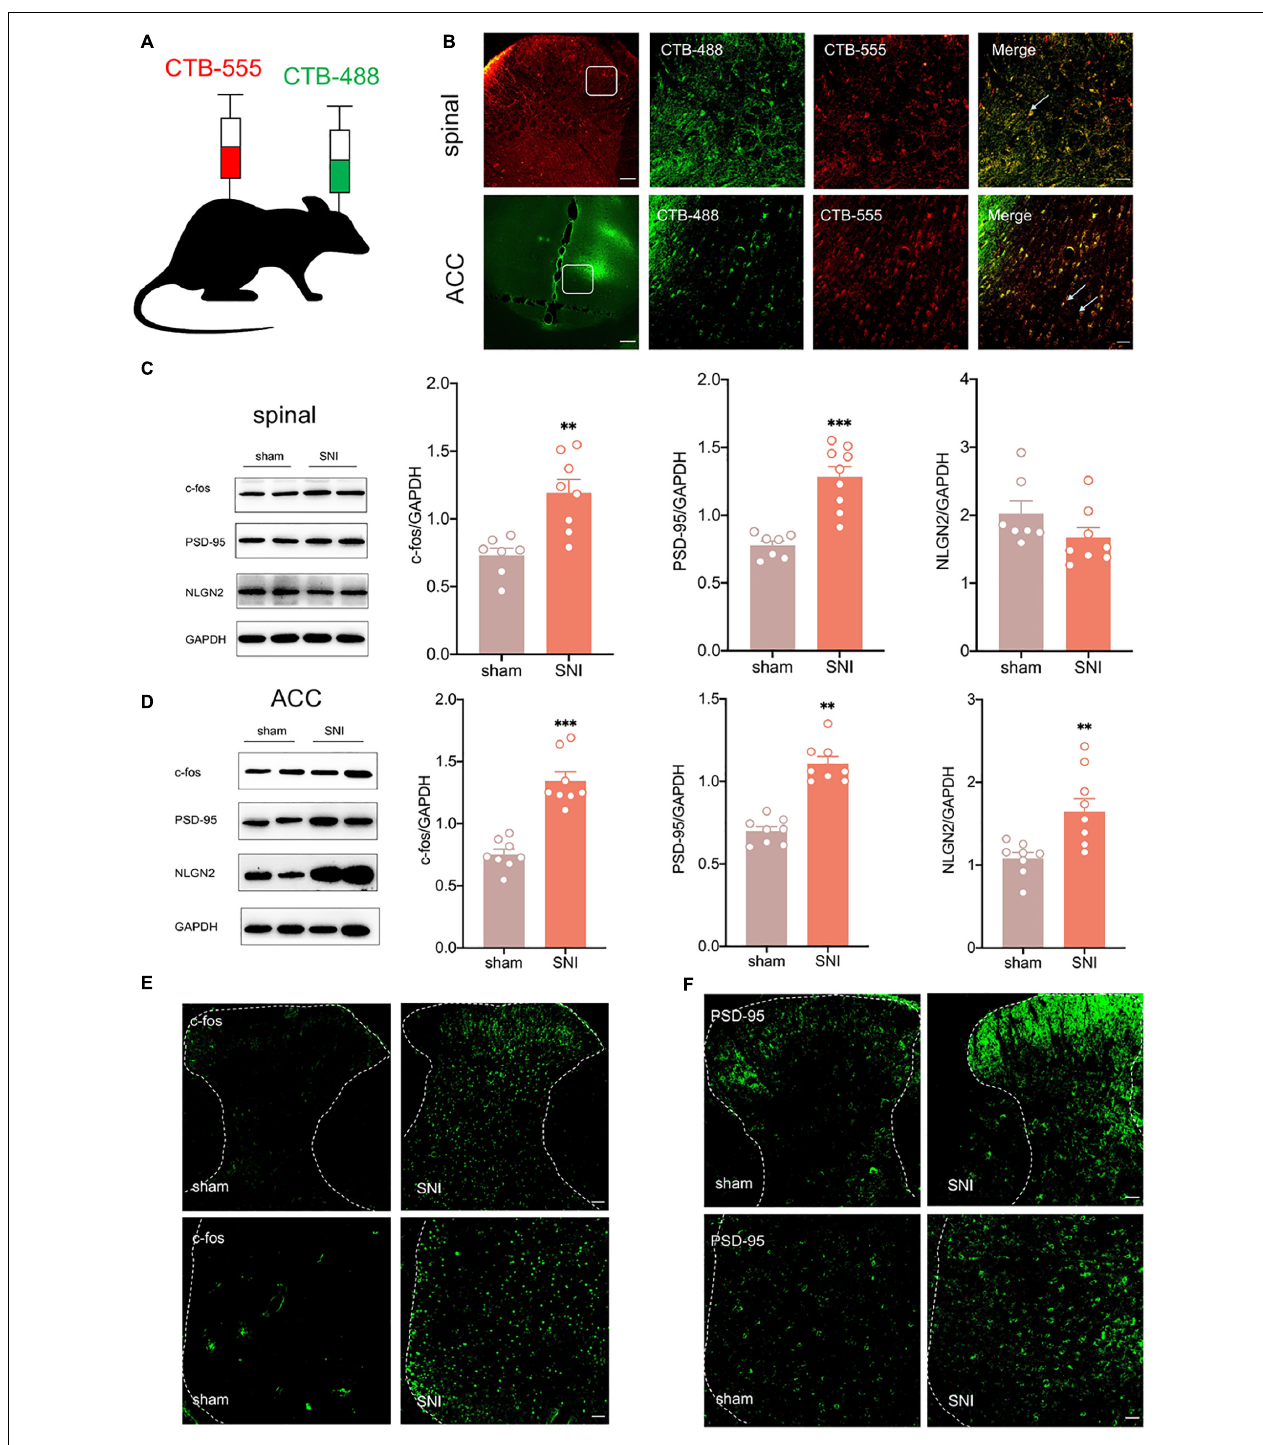
FIGURE 2 | There is a reciprocal projection between the ACC and the spinal cord, and peripheral nerve injury activates the spinal cord and the ACC. (A) CTB-555 (green, 250 nl) and CTB-488 (red, 250 nl), respectively, were stereotaxically injected into the ipsilateral spinal dorsal horn and contralateral ACC (Scar bar = 50 µ m). (B) Immunofluorescence showed that coexpression signals (yellow) of CTB-555 and CTB-488 were observed in the injected area of the spinal dorsal horn and ACC. (C) The expression of c-fos and PSD-95 was increased in the spinal cord of SNI rats ( n = 8 rats/group). (D) The expression of c-fos, PSD-95 and NLGN2 was increased in the ACC of SNI rats ( n = 8 rats/group). (E) Peripheral nerve injury activated ipsilateral spinal cord and contralateral ACC (Scar bar = 50 µ m). (F) Peripheral nerve injury elevated PSD-95 in the ipsilateral spinal cord and contralateral ACC (Scar bar = 50 µ m). ∗∗ P < 0.001, ∗∗∗ P < 0.0001 for sham vs. SNI.